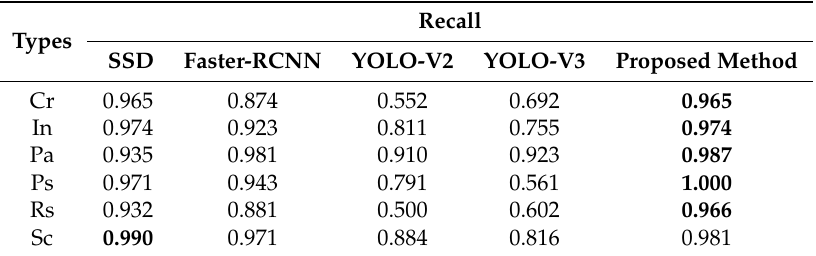
Table 2. Comparison of Recall on NEU-DET dataset. The proposed method performs the highest Recall values for five defect categories. The bold helps to emphasize the highest data.